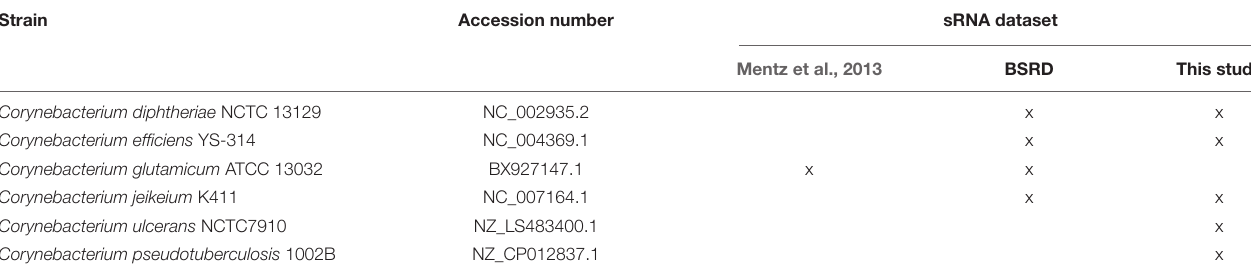
TABLE 1 | The sRNA datasets and target species. Strain Accession number sRNA dataset